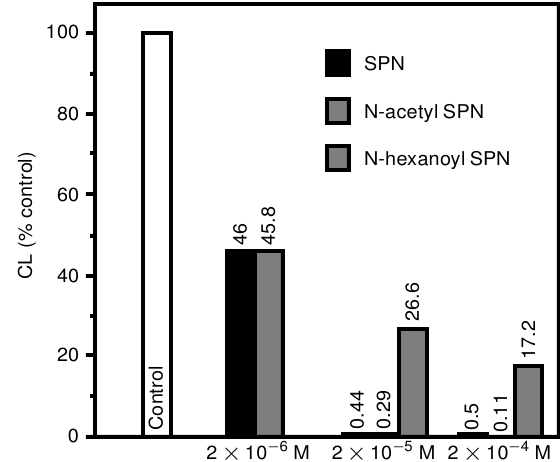
FIG. 6. Comparison of the effects of SPN analogues with those of SPN on luminol enhanced CL (in % control)